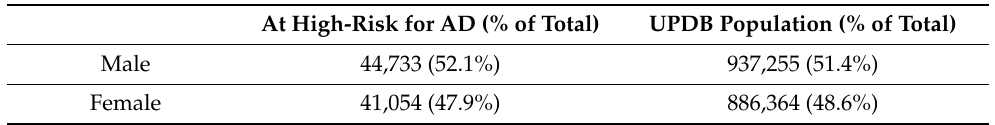
Table 3. Sex distribution for 85,787 individuals at high-risk for AD compared to the over 1.8 million individuals with extensive genealogy linked to Utah founders in the UPDB population (Pearson’s chi-squared test p = 1.8 × 10 − 5